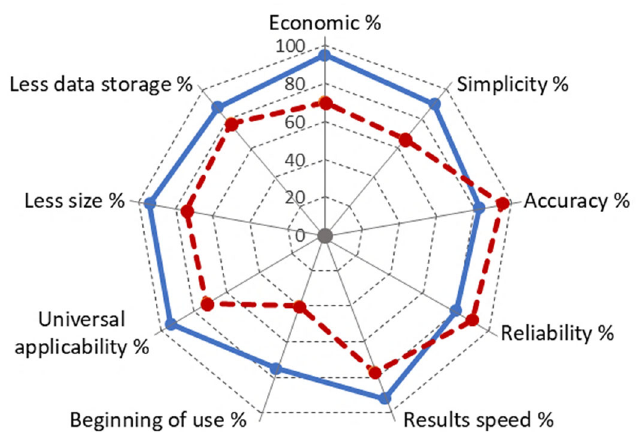
Figure 1. Comparison of different aspects of PV cleaning units (blue) without using an additional device and (dotted red) with using additional devices.